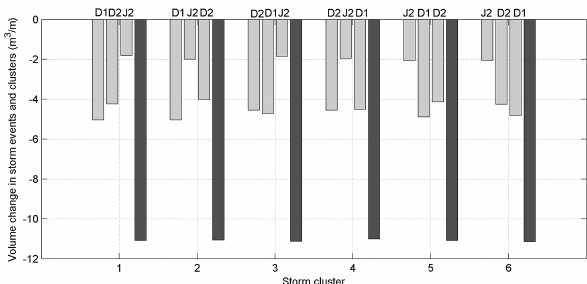
Figure 8. Comparison of the volume change from MSL to + 6m ODN during each storm event and cluster. Grey bar at D1, D2 and J2 indicates volume change within the respective storm and black bar shows volume change within a